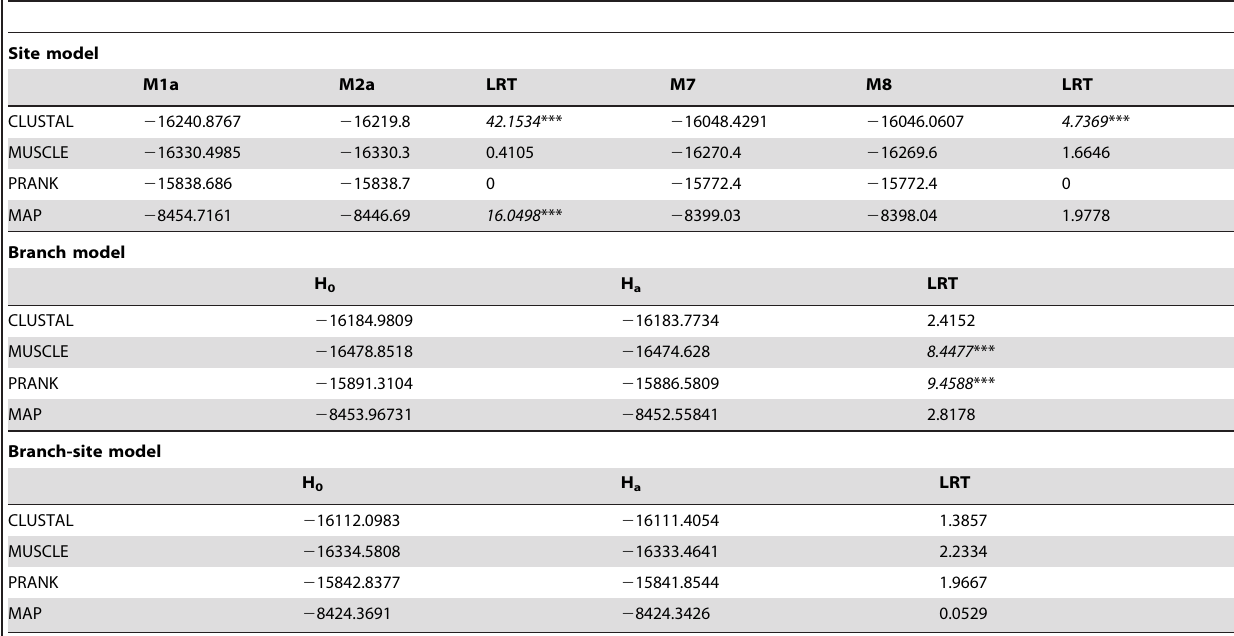
Table 3. Results of the selection analyses for the best alignment method (PRANK), and two others (CLUSTAL and MUSCLE) and the MAP dataset of Solenopsis